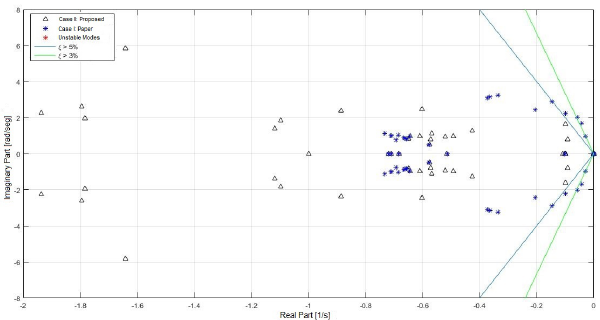
Figure 26. Eigenvalues in heavy load operation condition.